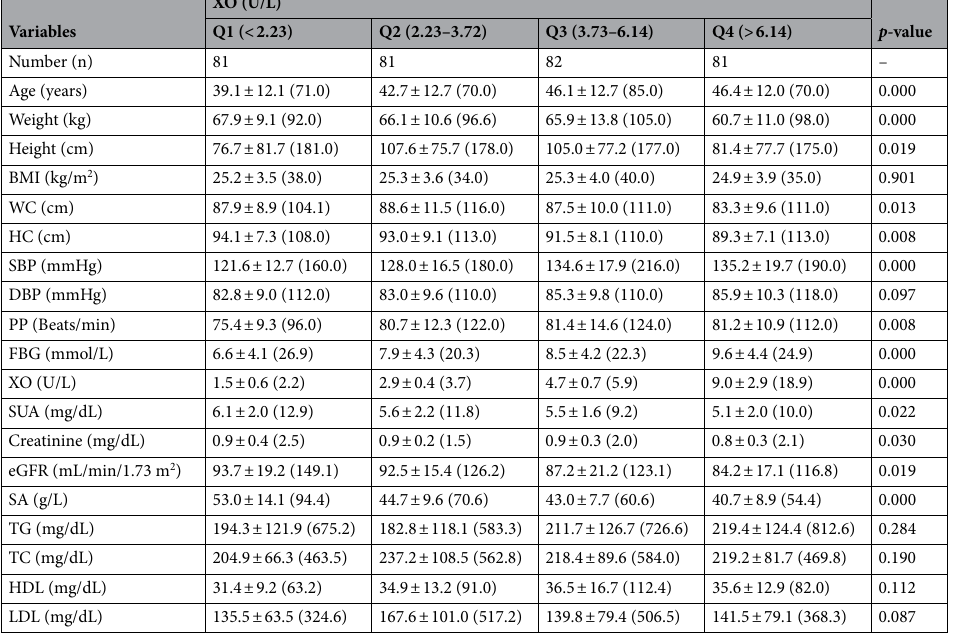
Table 3. Baseline characteristics of the study subjects in the XO quartiles. Values are presented as mean ± SD with maximum values in parentheses. p-values are obtained from one-way ANOVA.